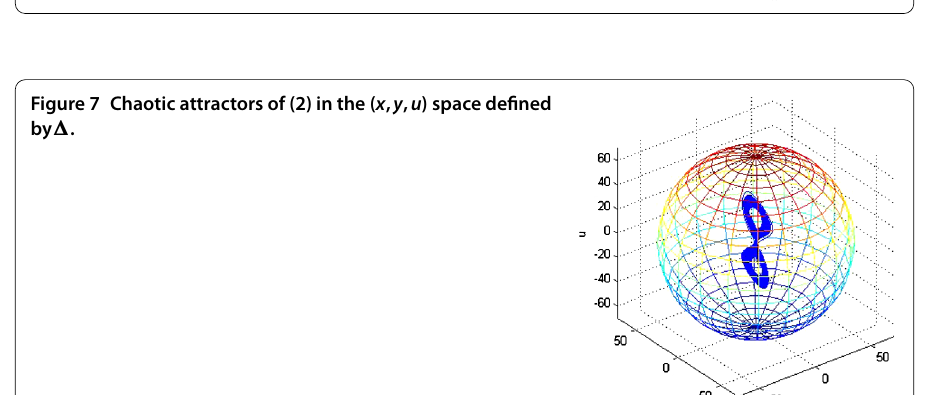
Figure 8 Chaotic attractors of (2) in the ( x , y , ω ) space defined by (cid:2) .